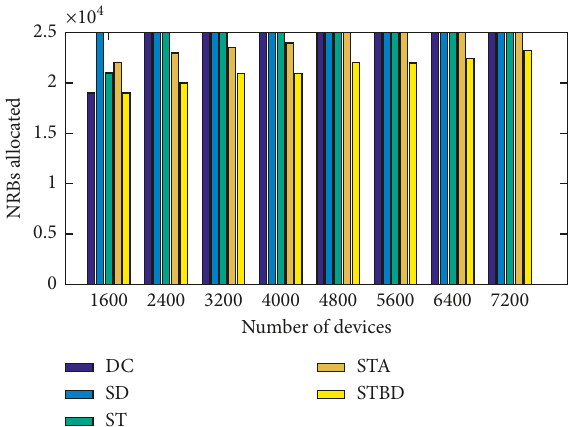
Figure 3: Number of requests from devices compared with number of served